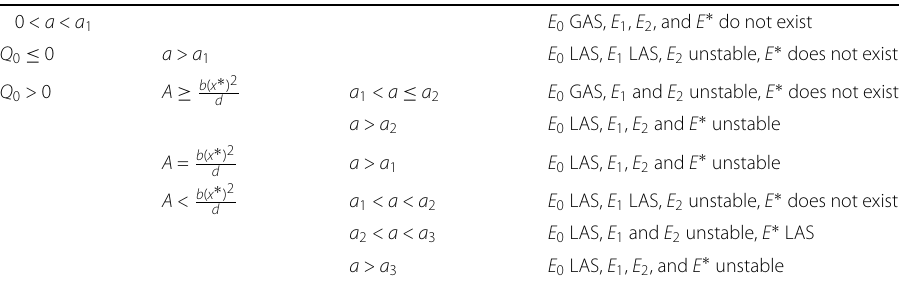
Table 5 Equilibria E i , i = 0,1,2, and E ∗ of system (4) with τ = 0